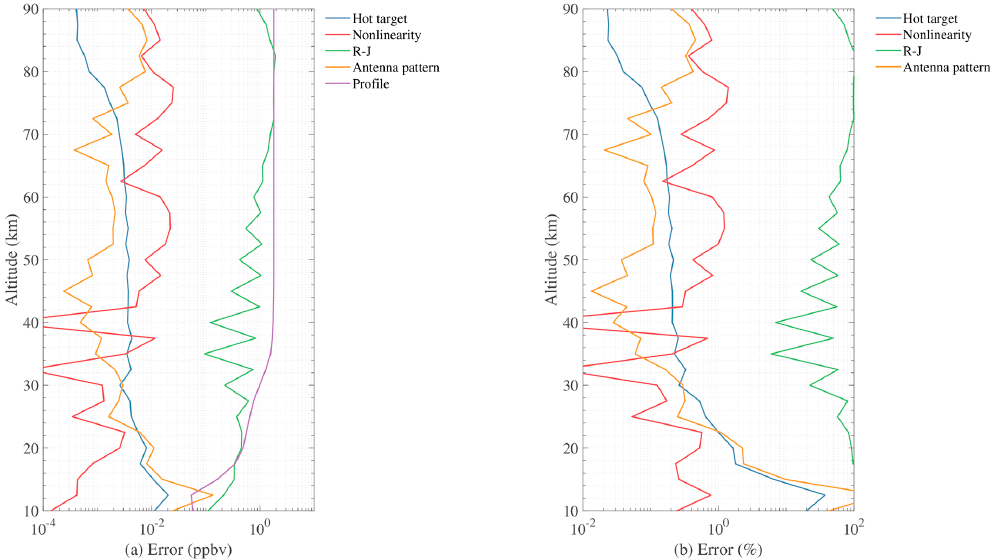
Figure 19. The HCl retrieval errors induced by different calibration error sources: ( a ) absolute and ( b ) relative retrieval errors. The uncertainties assumed are summarized in Table 4.